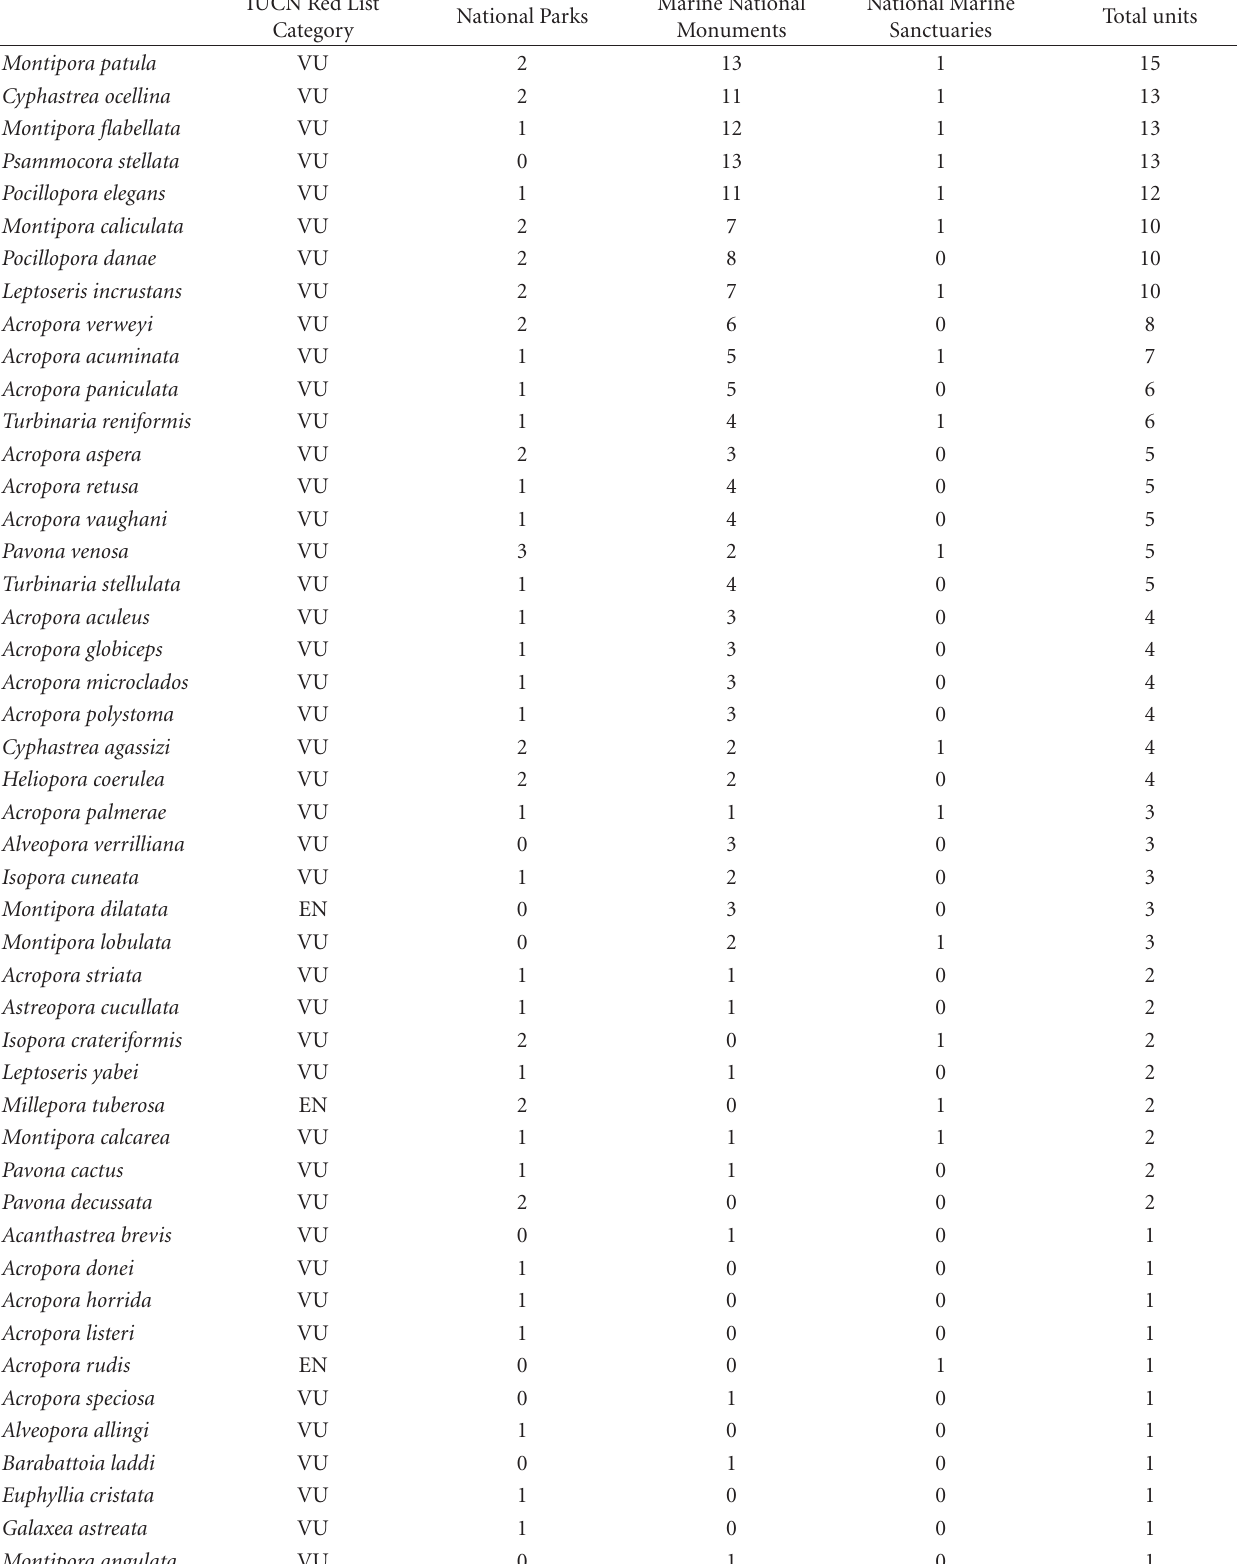
Table 3: IUCN Red List Categories for 66 species with substantiated records of occurrence in the US Pacific, ranked by number of units (geographically distinct islands, atolls, or reef systems) where found within federally protected